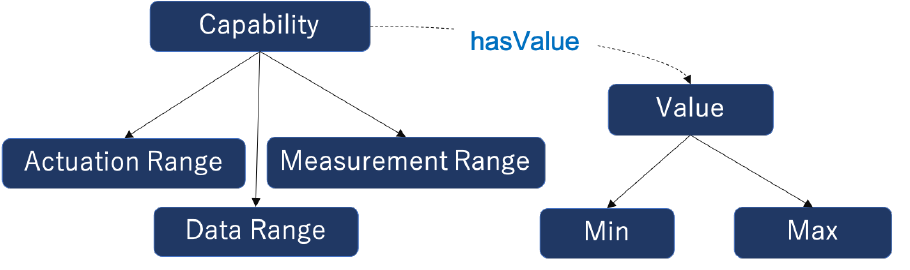
Figure 7. A subtree of capability.